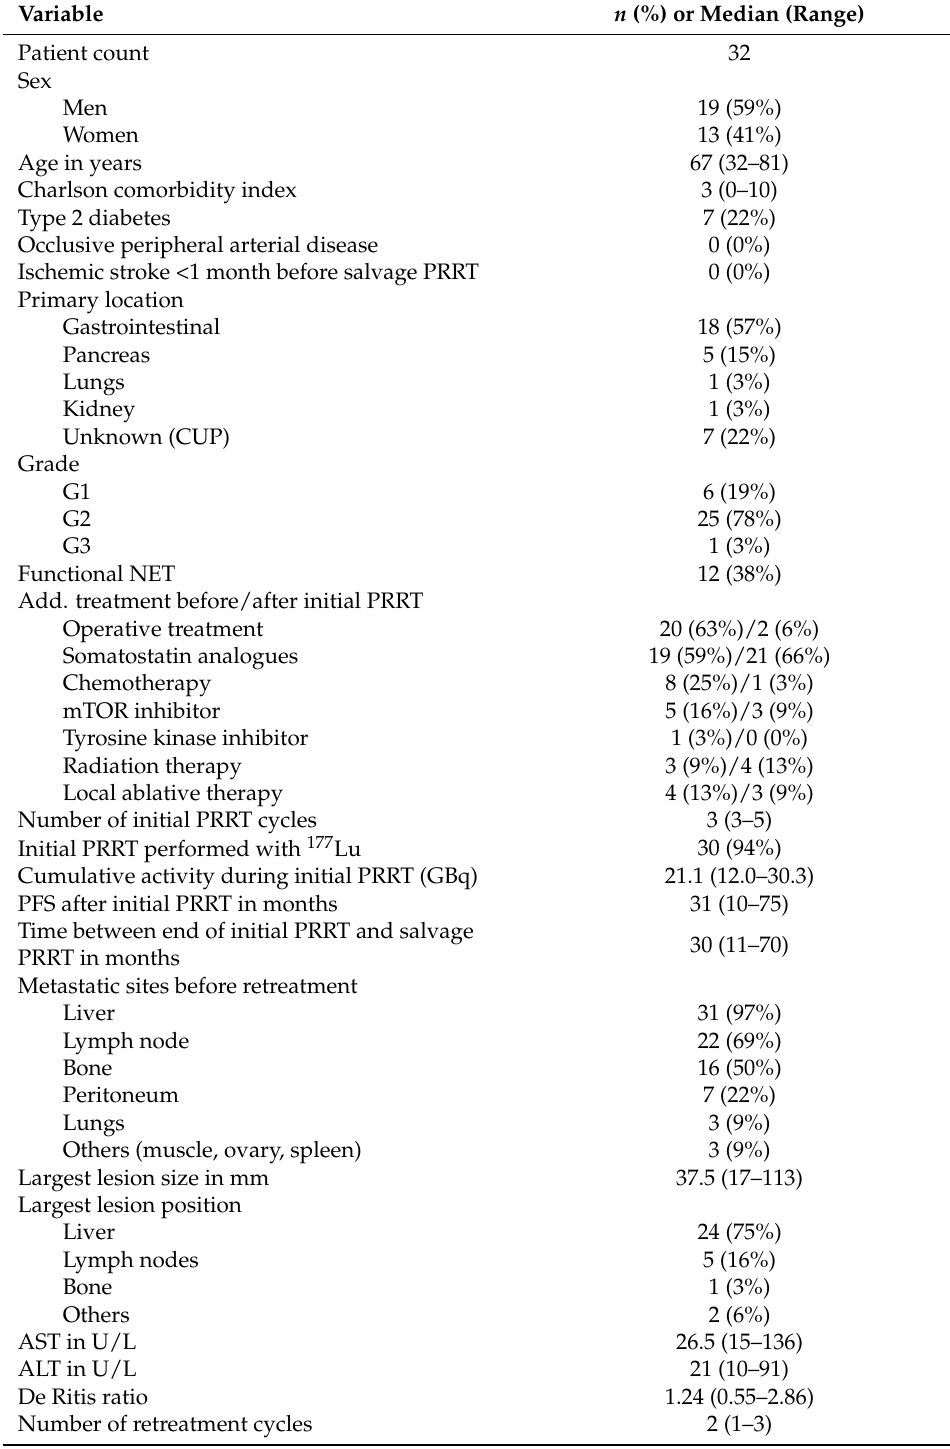
Table 1. Patient